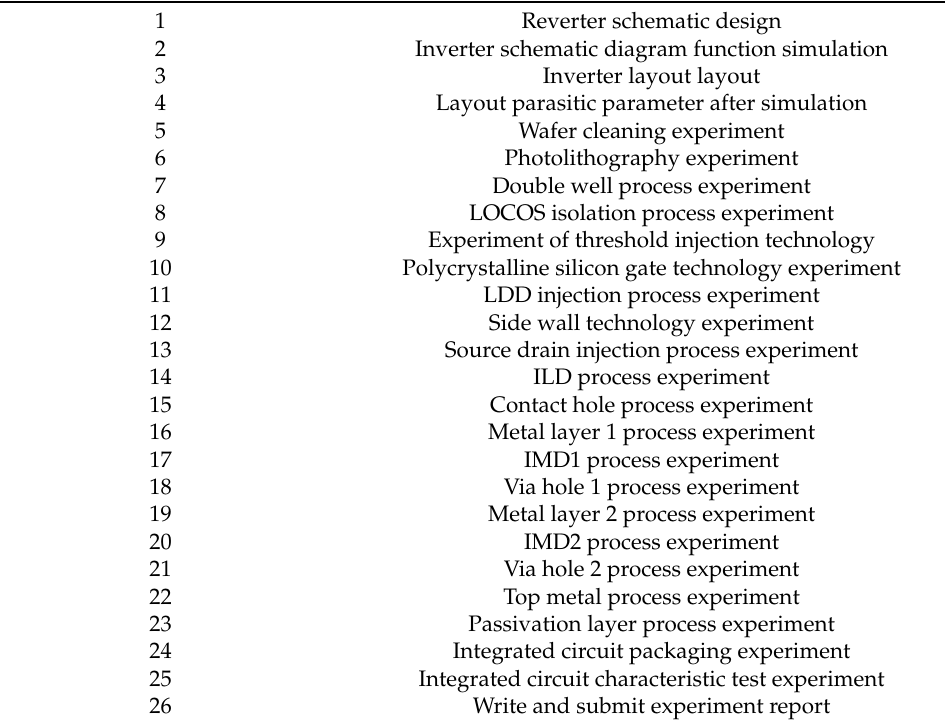
Table 1. Knowledge chain of